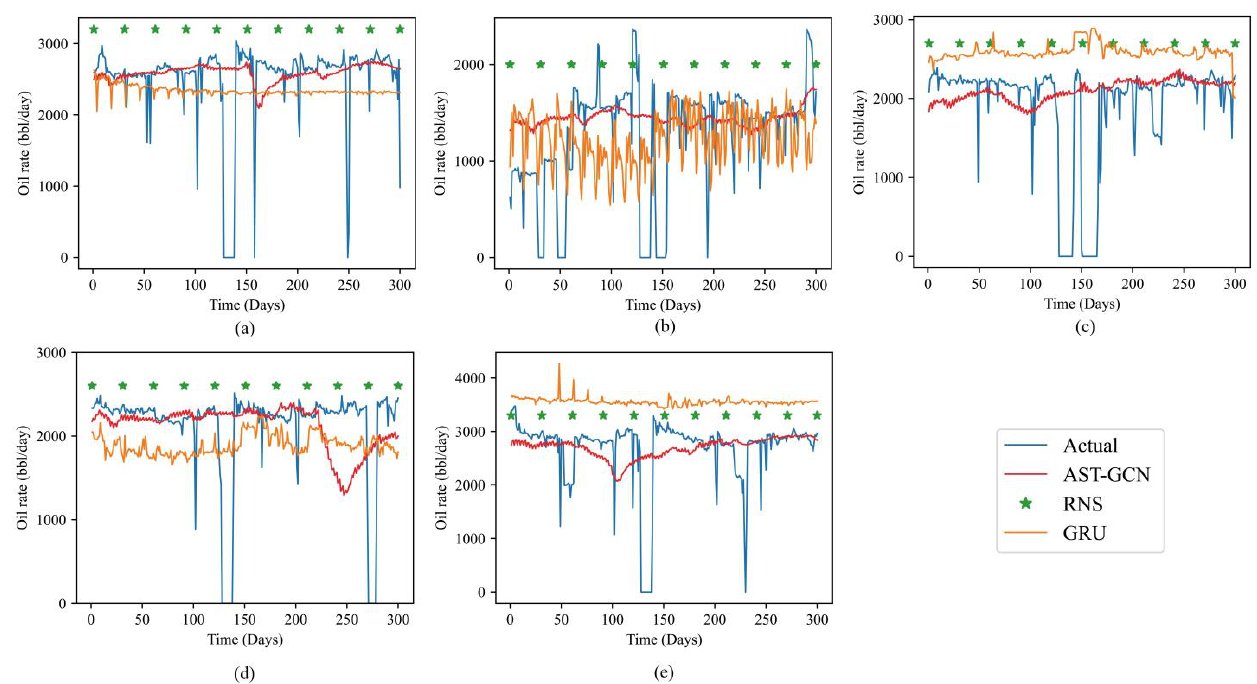
Figure 11. The predictive performance of daily oil production using the different models: ( a ) P1 well; ( b ) P2 well; ( c ) P3 well; ( d ) P4 well; ( e ) P5 well.